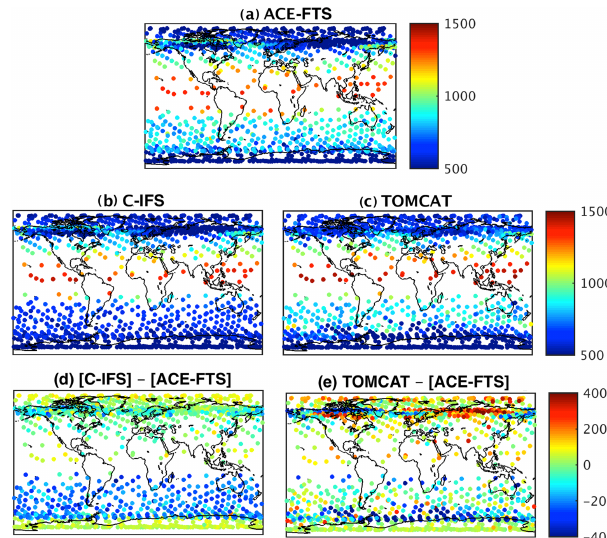
Figure 8. Maps showing the CH 4 concentration (in ppb) at the 10hPa pressure level for the months September to November 2010. Panel (a) shows the CH 4 concentration as measured by ACE. Pan- els (b) and (c) show the CH 4 concentration modelled by the C-IFS and TOMCAT, respectively, sampled at the location and times of the MIPAS measurements. Panels (c) and (d) show the bias between the models and the ACE measurements.